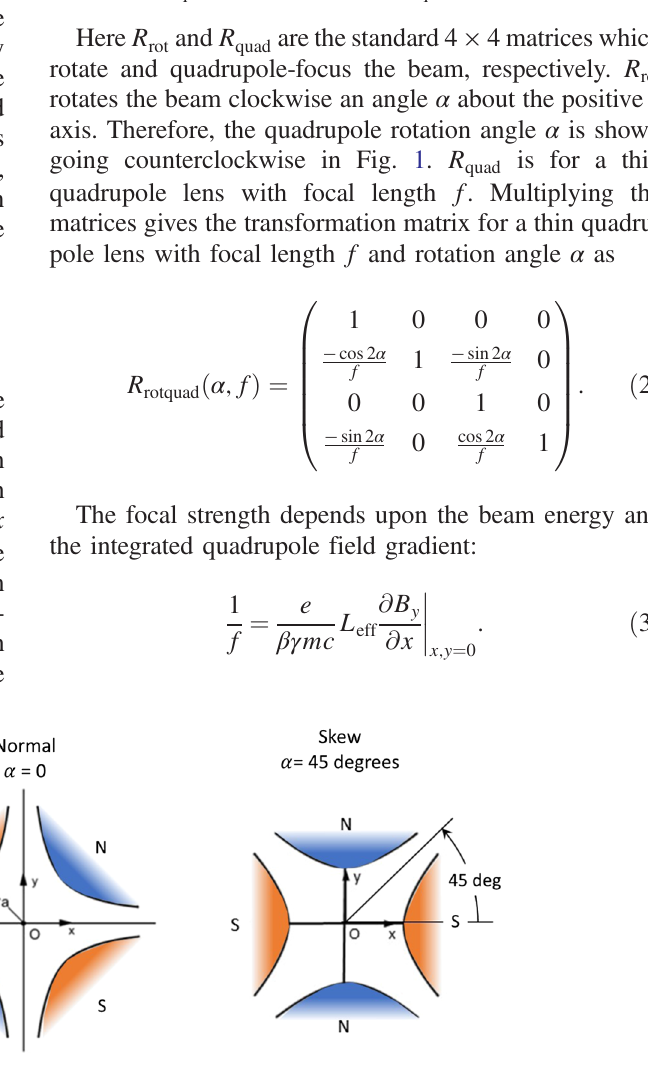
FIG. 1. Magnetic equipotential surfaces for rotated, normal, and skew quadrupole fields. The coordinate system is right-handed with the z axis pointing out of the page. The normal-quadrupole field is focusing in the x plane and defocusing in the y plane for electrons traveling along the þ z